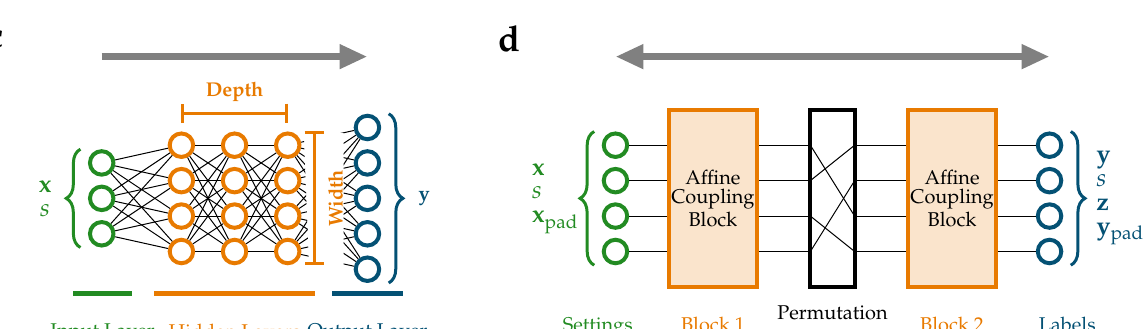
Figure 3. Optimisations with OPAL ( a ) and the forward model ( b ). The gray parts correspond to current practice, the blue parts belong to the genetic algorithm (GA) NSGA-II and the orange parts are our novel contributions. The GA generates n g generations. Schematics of the forward model ( c ) and invertible model ( d ) architectures. The grey arrows denote the prediction